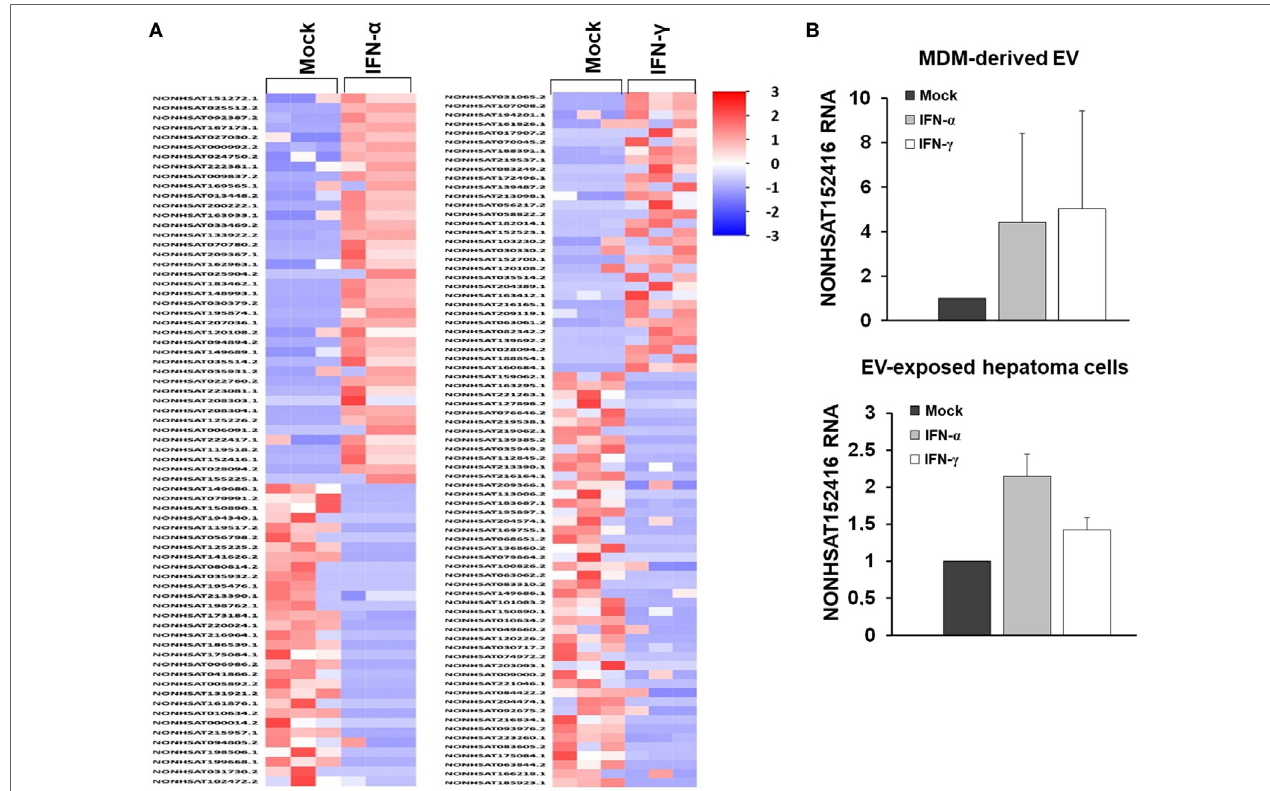
FigUre 5 | RNA sequencing of long-non coding RNA species of MDM-derived extracellular vesicles (EVs). (a) Heat map of long-non coding RNAs of EVs derived from three different donors. (B) Quantitative PCR of an exemplary long-non coding RNA (NONHSAT152416), relative to GAPDH, in MDM-derived EVs and in human hepatoma cells exposed to MDM-derived EVs (mean and SEM of three biological replicates are